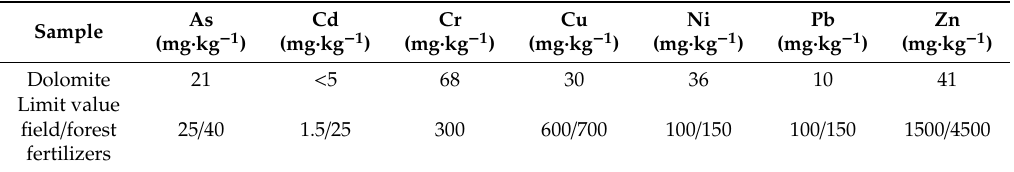
Table 2. Harmful element contents (XRF) and a comparison to the limit values of Finnish fertilizer decree